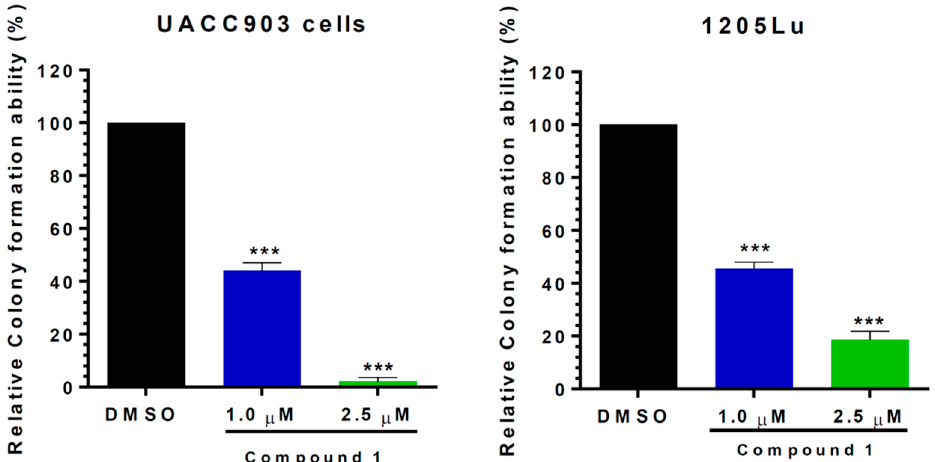
Figure 2. Compound 1 dramatically reduced the colony formation ability of melanoma cells. 1205Lu ( A ) and UACC903 ( B ) cells were treated with 1 or 2.5 µ M of compound 1 or dimethyl sulfoxide (DMSO) (control) for 24 h. Subsequently, 500 cells were re-seeded with free compound 1 or DMSO medium for 14 days and stained with 0.5% alcoholic crystal violet. The results are expressed as mean ± SD. *** p < 0.001.